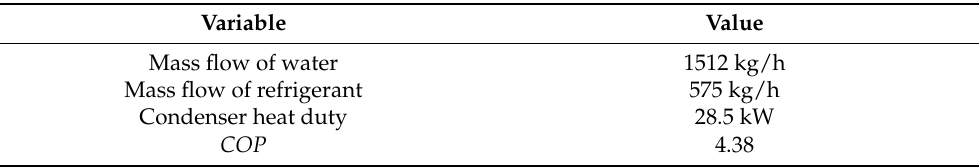
Table 3. Values of variables obtained with simulation in Aspen Plus.